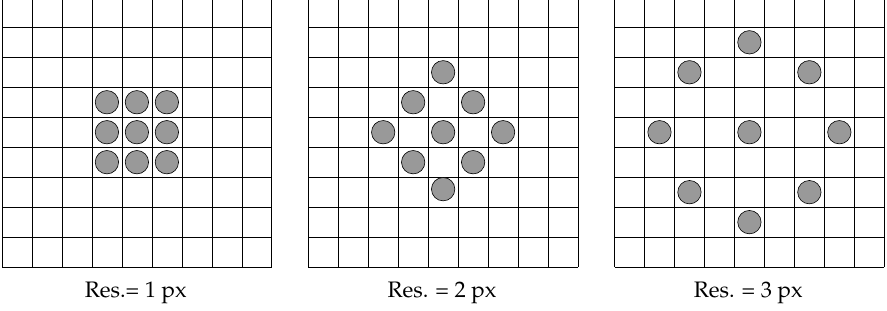
Figure 11. Neighbourhoods used to compute features through histograms of equivalent patterns and other